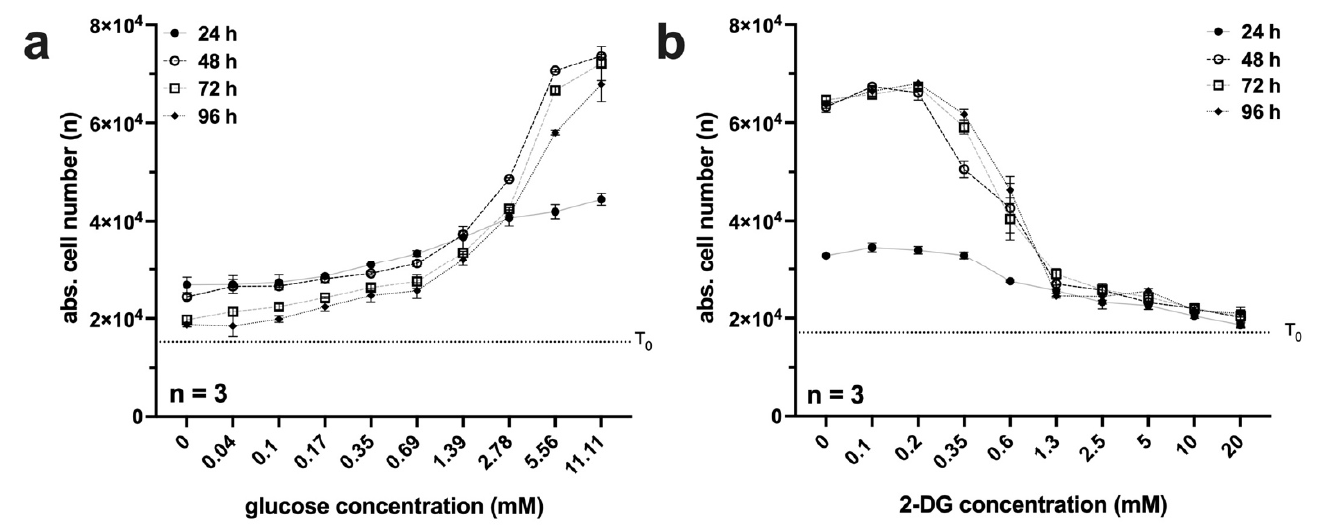
Figure 2. ( a , b ) Analysis of proliferation under glucose restriction or with the 2-DG glycolysis inhibitor in L929 cells. A total of 1 × 10 4 cells per well were seeded on 96-well plates. On the following day, the cells were incubated in triplicate with ( a ) 11 mM glucose or ( b ) 20 mM 2-DG with a log(2)-dilution series. After 24, 48, 72, and 96 h, absolute cell numbers (n) were analysed via automated digital microscopy (Pico). The results and standard deviation of three independent experiments are shown. The cell number (T 0 ) at the beginning of the experiment was also determined and is shown as a dashed line in the diagram.